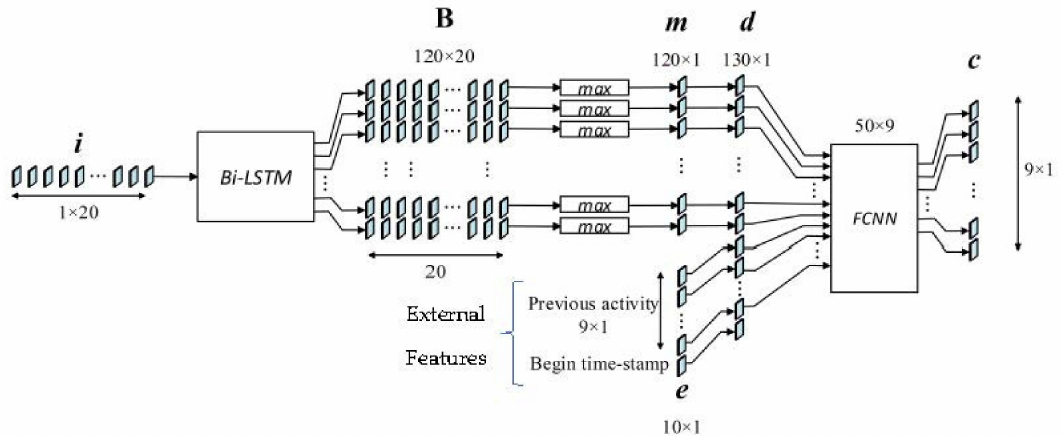
Figure 3. Architecture of the proposed model with its data flow.